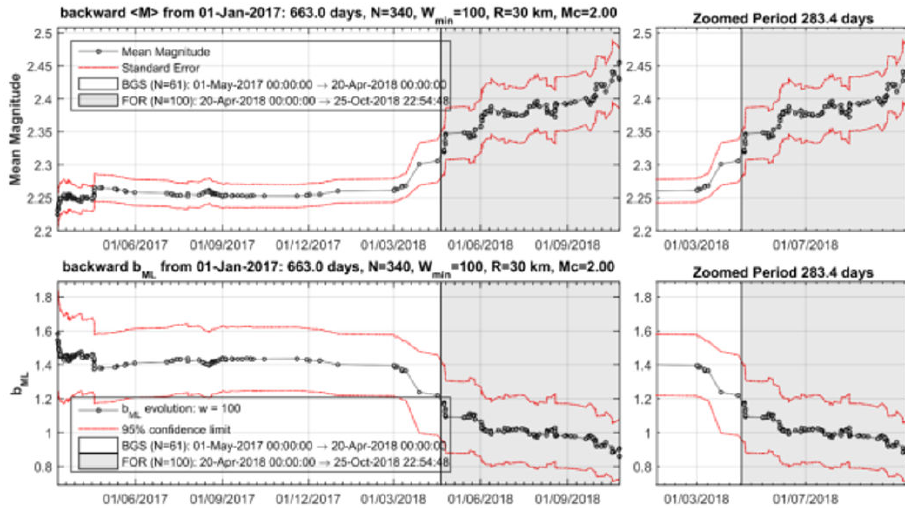
Figure 16. Variation of < M > (upper panel) and b ML (lower panel) for the seismicity plotted in Figure 13. After the 1 May 2017–20 April 2018 background seismicity state (BGS 2), < M > increased while b ML decreased systematically during the foreshock activity (cluster 2-FOR, grey-shaded area, 20 April 2018–25 October